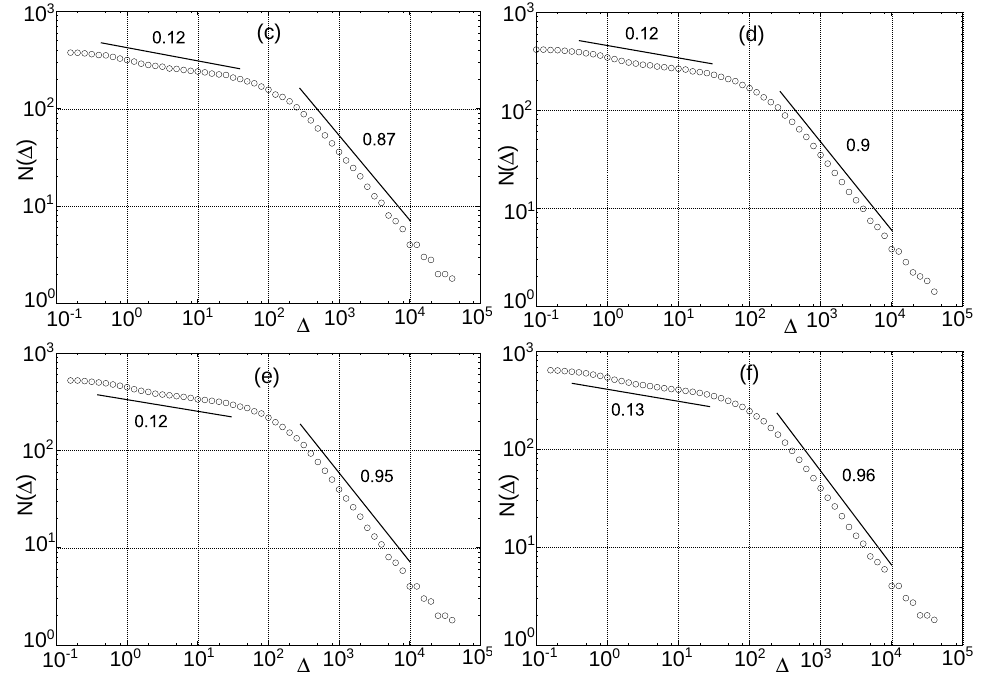
Figure 6. Number of N ( ∆ ) intervals of ∆ length, which contain at least one reversal. The α -quenching by helicity ( γ = 0). ( a ) ν = 2.0; ( b ) ν = 2.2; ( c ) ν = 2.3; ( d ) ν = 2.6; ( e ) ν = 2.8; ( f ) ν = 3.3.